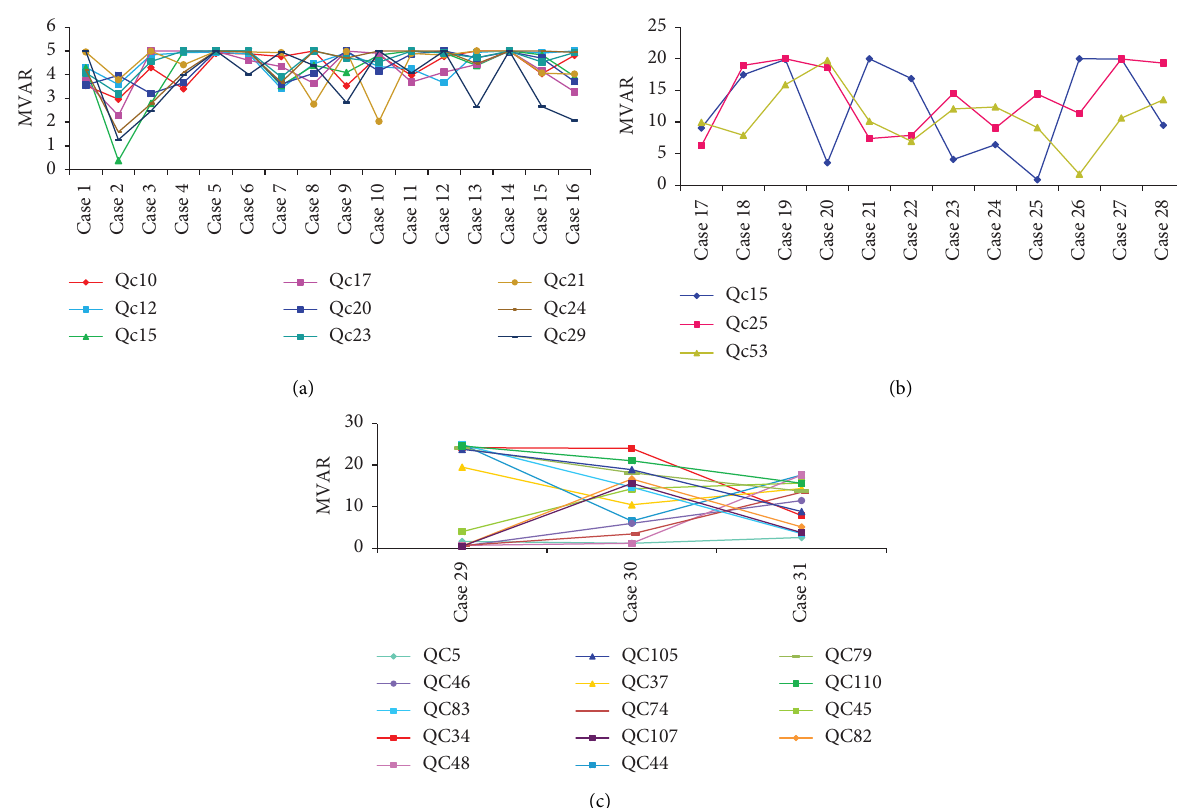
Figure 18: Compensator values comparison for all cases: (a) 30-bus; (b) 57-bus; (c)